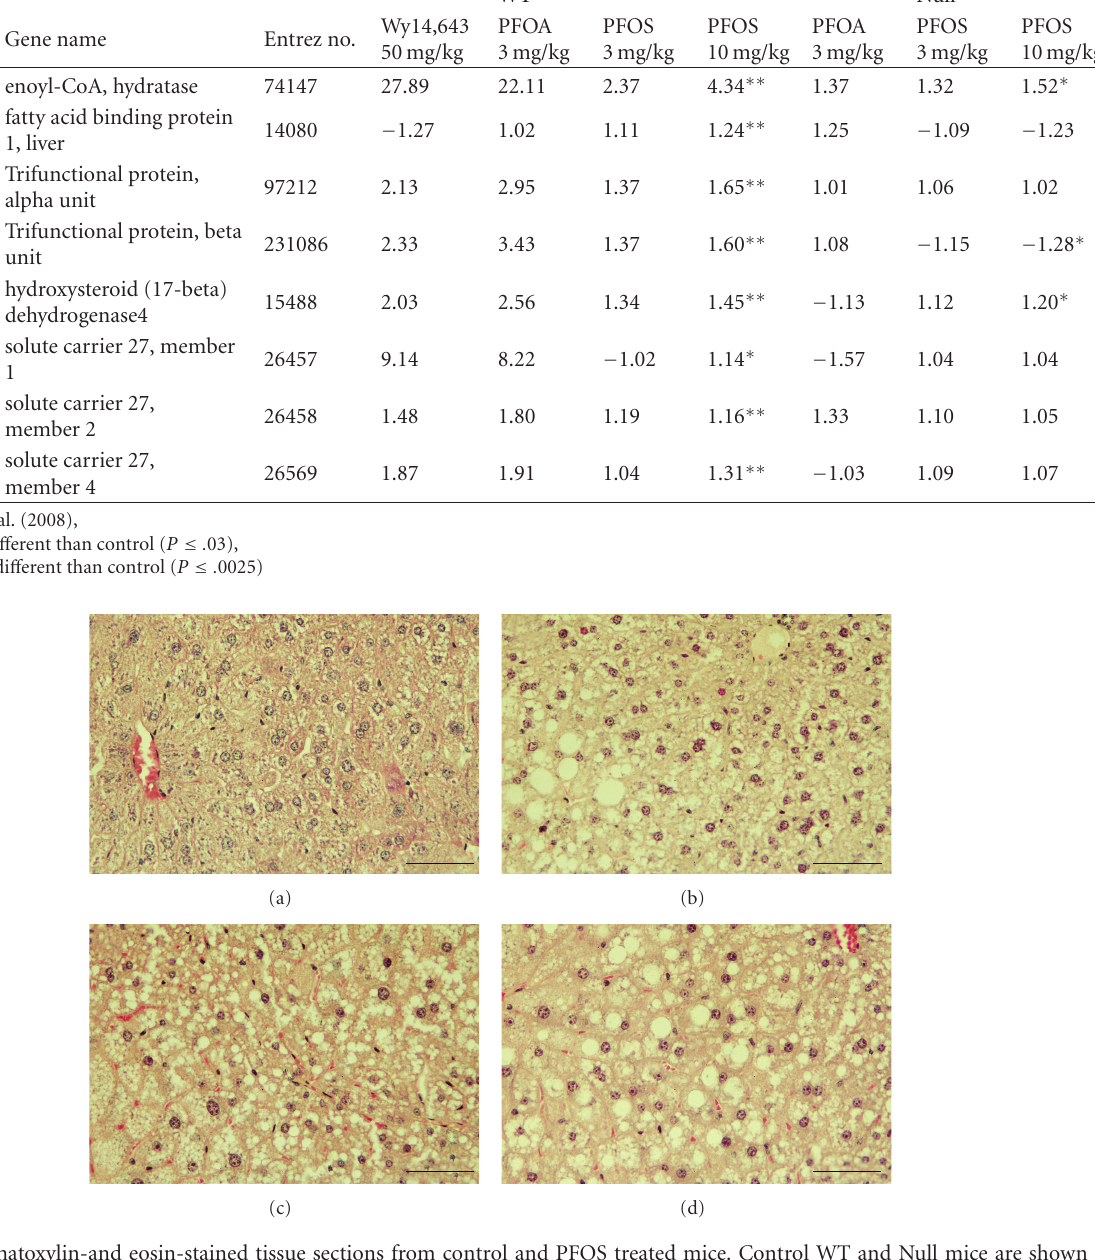
Figure 1: Hematoxylin-and eosin-stained tissue sections from control and PFOS treated mice. Control WT and Null mice are shown in panels (a) and (b), respectively. WT and null mice treated with 10 mg/kg/day PFOS are shown in panels (c) and (d), respectively. Vacuole formation was observed in sections from treated WT mice, and in sections from control and treated Null mice. Mice exposed to 3 mg/kg/day PFOS were similar to controls (data not shown). Bar = 50 μ